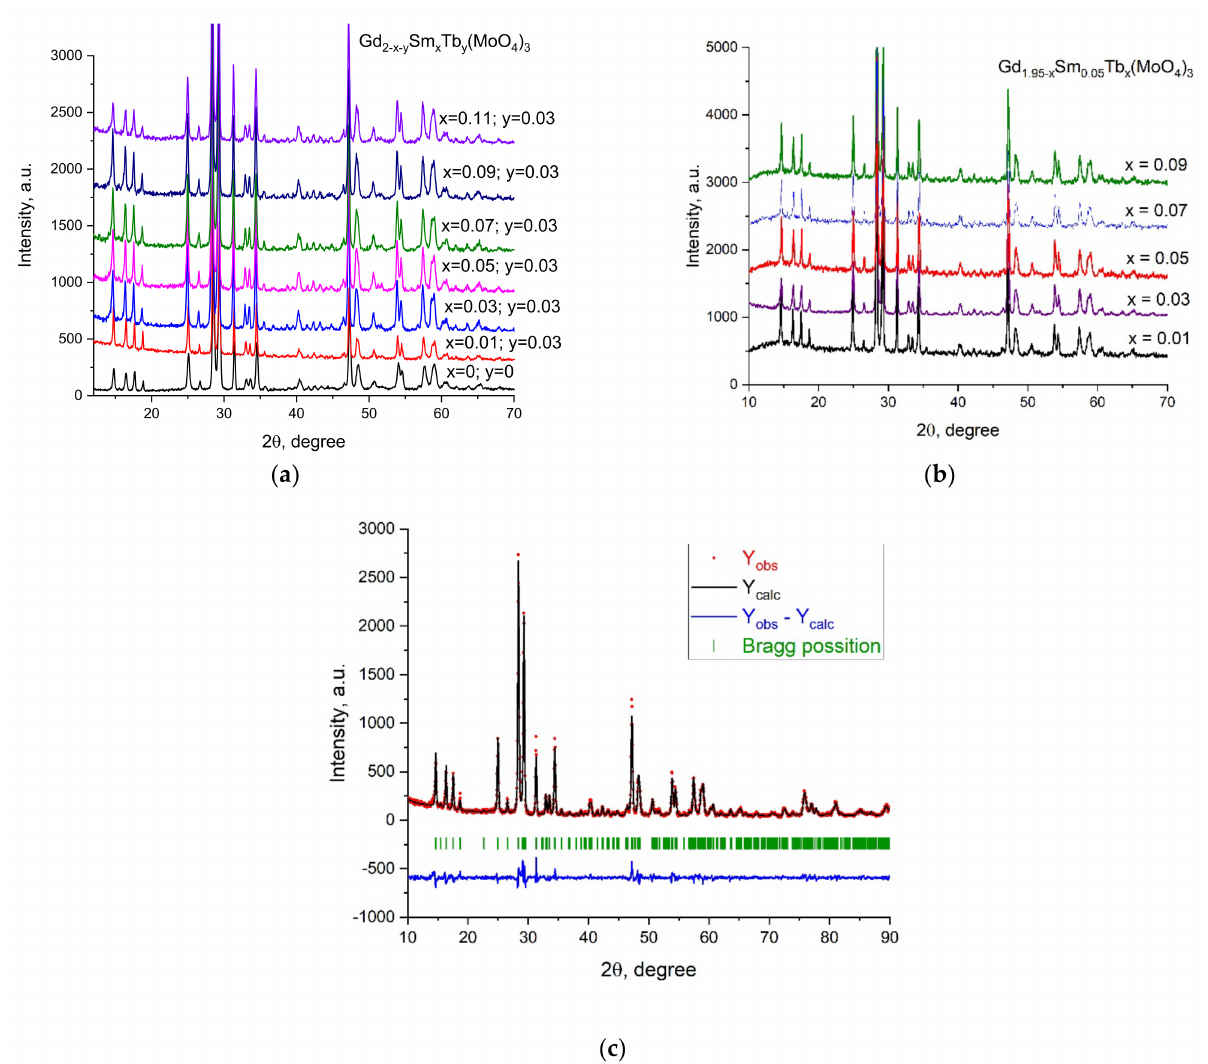
Figure 1. XRD of the samples: ( a ) Gd 2 − x − y Sm x Tb y (MoO 4 ) 3 and ( b ) Gd 1.95 − x Sm 0.05 Tb x (MoO 4 ) 3 . ( c ) Experimentally observed (dots), Rietveld-calculated (continuous line) and difference (continuous bottom line) profiles, obtained after Rietveld analysis of the Gd 1.92 Sm 0.05 Tb 0.03 (MoO 4 ) 3 sample. Peak positions are shown on the base line as small